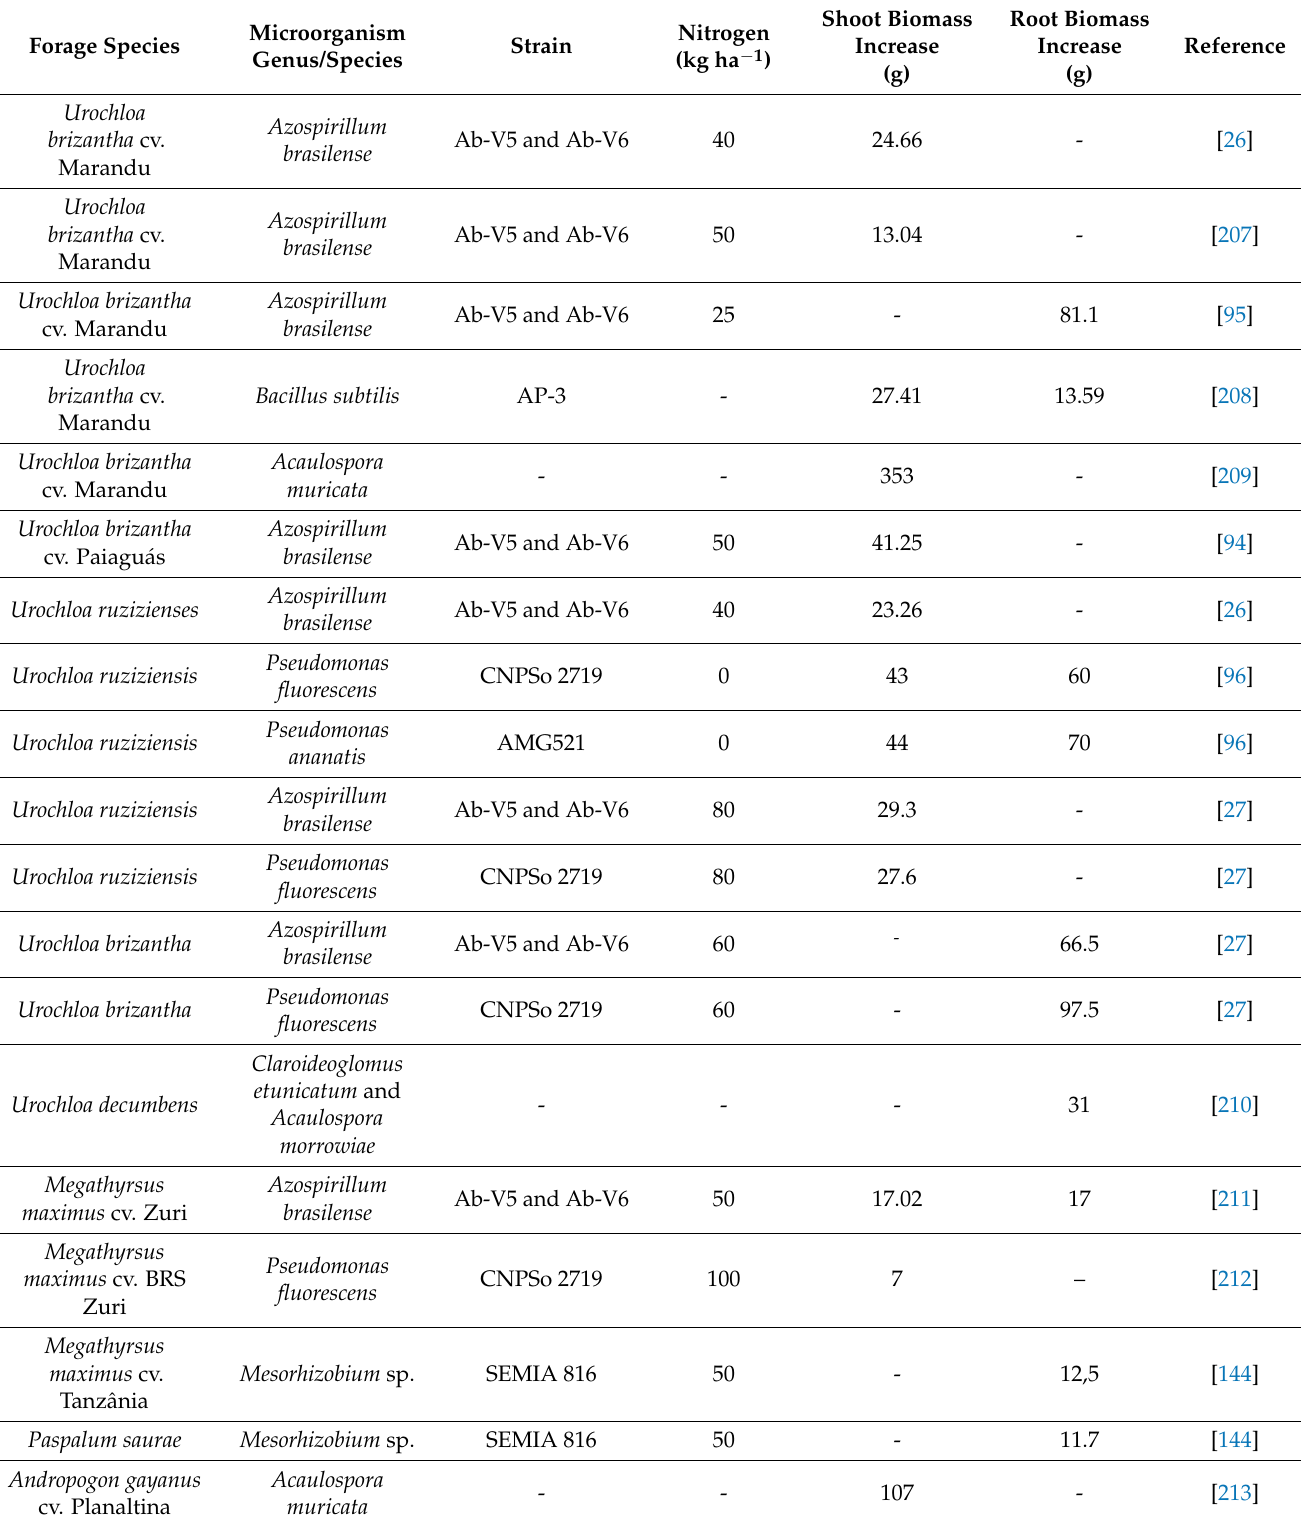
Table 1. Recent studies reporting the benefits of inoculation with plant growth-promoting microor- ganisms in forage grasses in